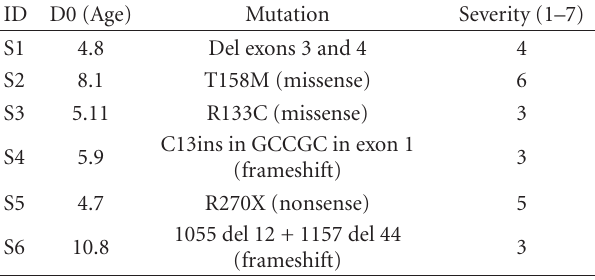
Table 1: Selected patients for the study. This table reports the pa- tients in the study, with their specific mutation, D0 and age at the beginning of the treatment. In addition, it reports the gravity of the disease (7 heavily impaired, 1 mildly